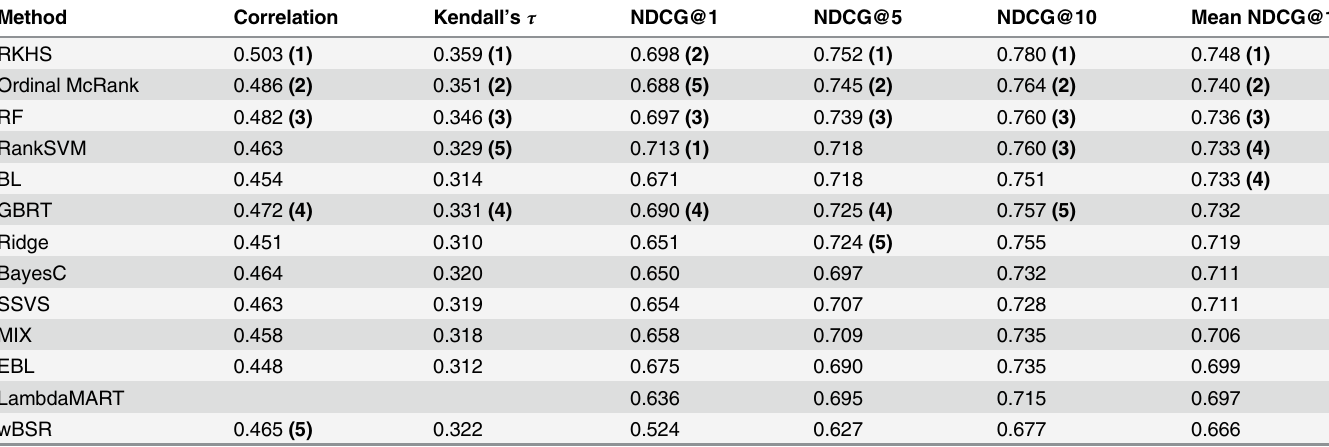
Table 6. Cross-validation results on the Wheat (CIMMYT) dataset, averaged across 4 traits. Method